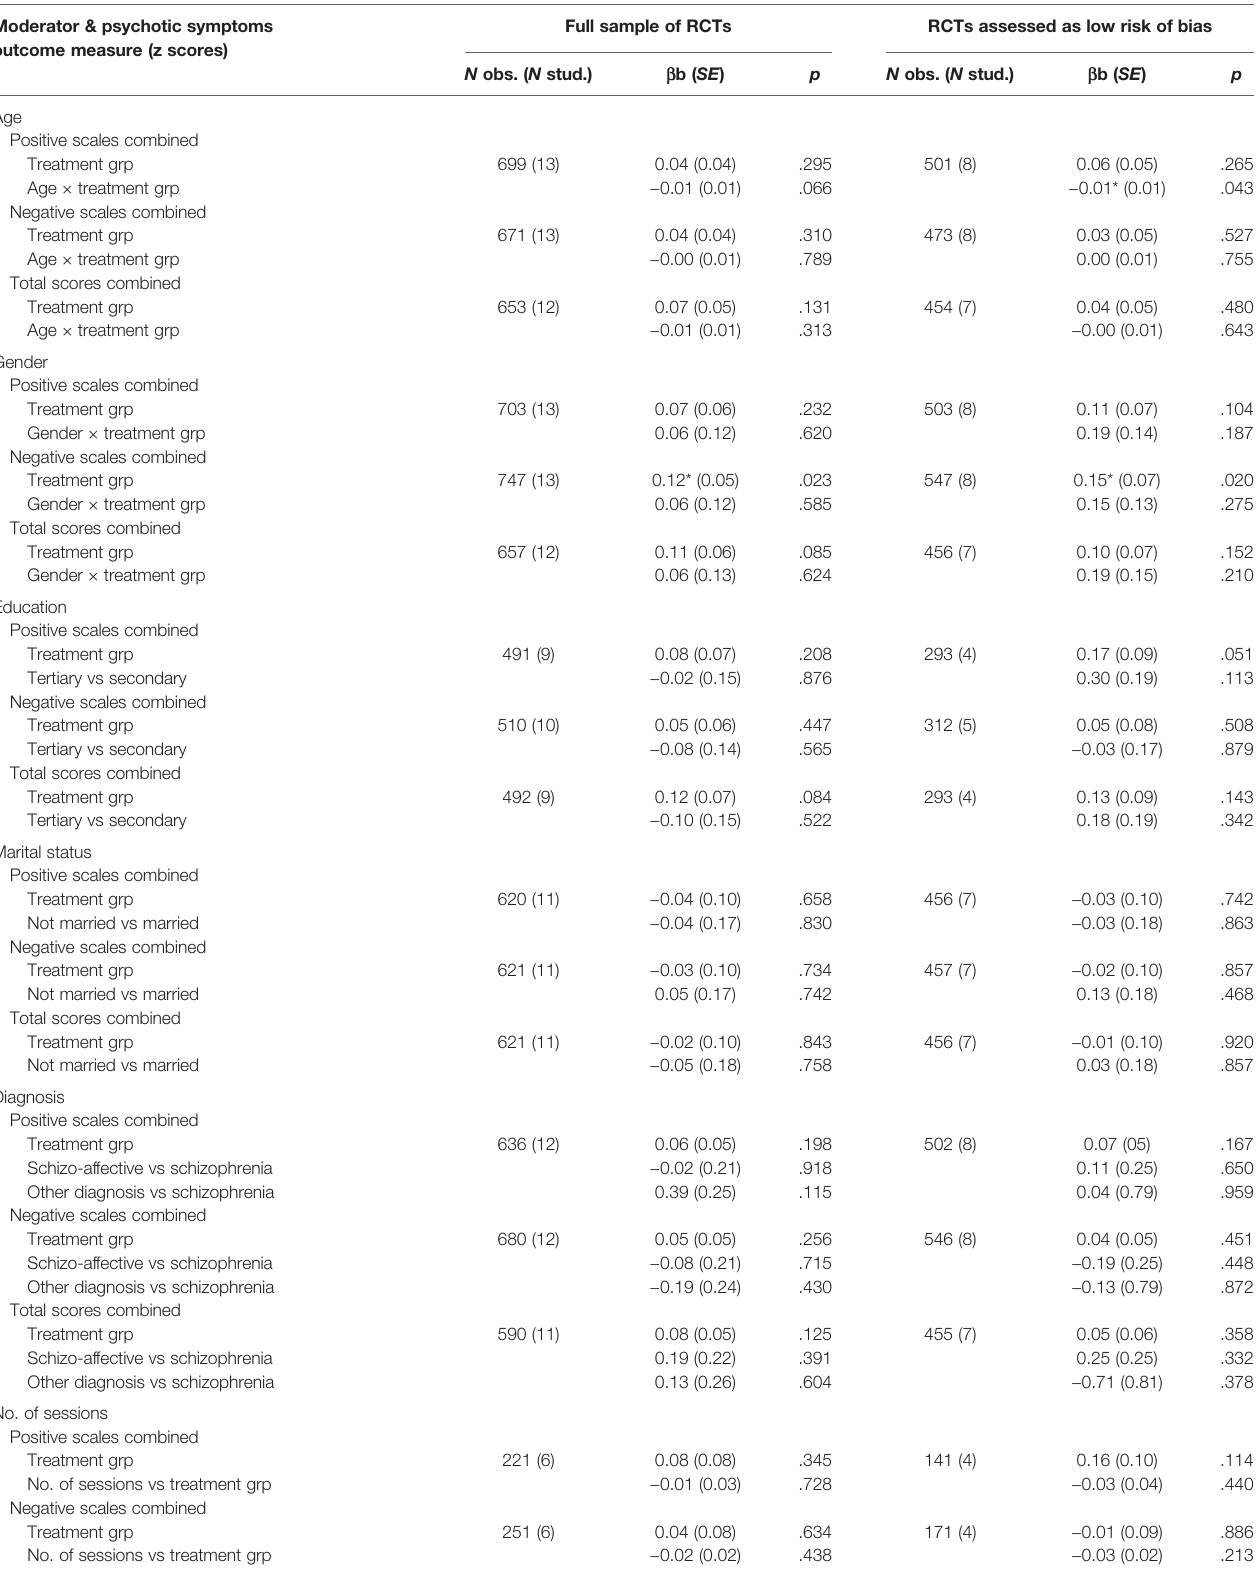
TABLE 3 | Results of moderator